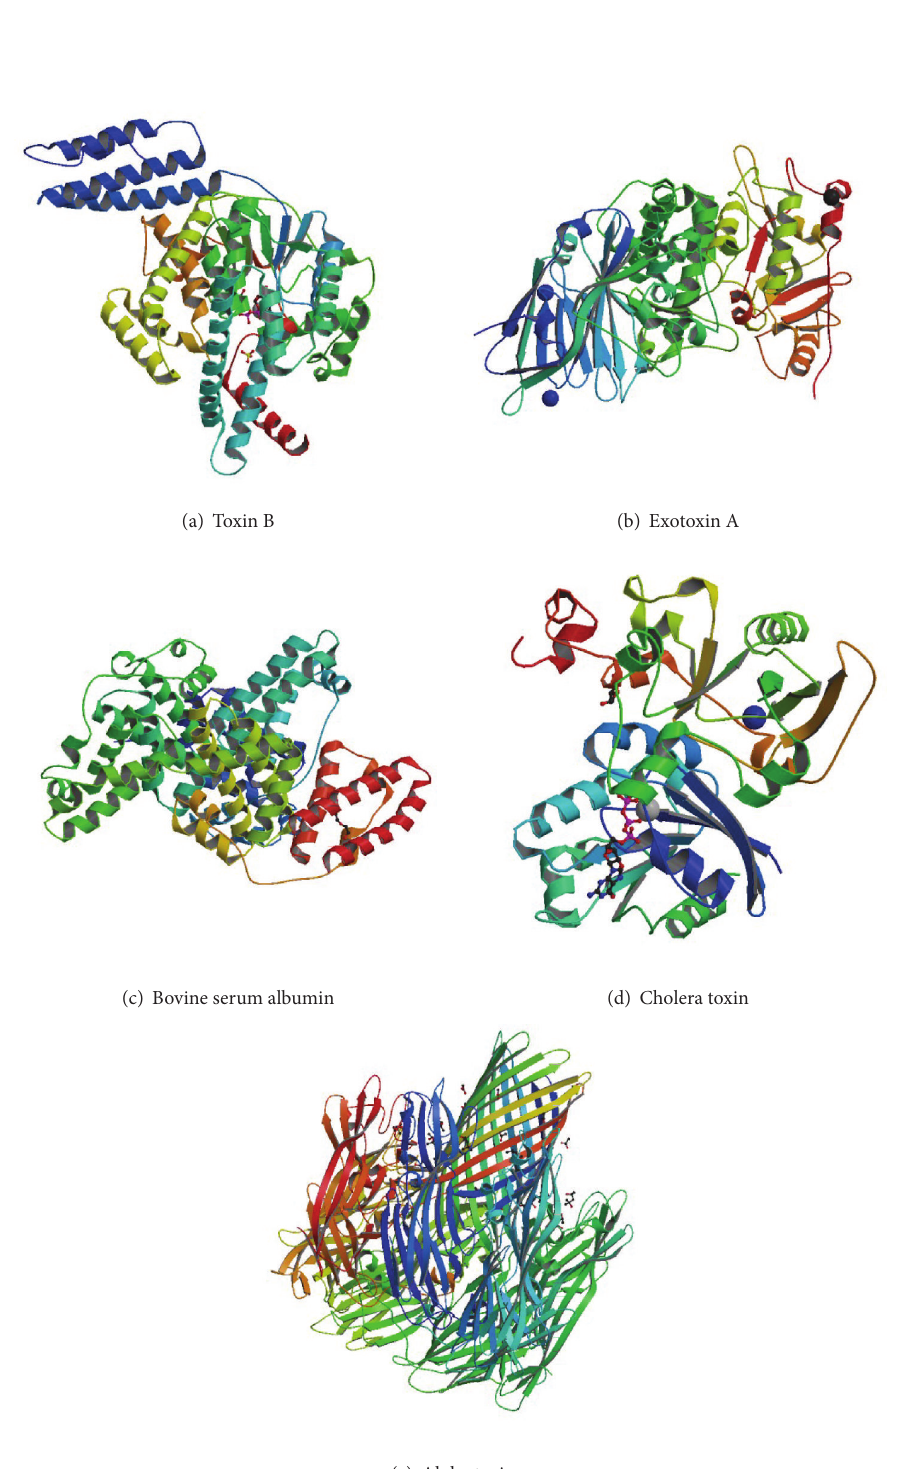
Figure 2: Structures of targets used in the SELEX scheme and cross binding assays. (a) Ribbon structure of the selection target, Clostridium difficile toxin B (PDB 2BVM, 270 kDa) [54]. ((b), (c), (d), and (e)) Ribbon structure of Pseudomonas aeruginosa exotoxin A (PDB 1IKQ, 66 kDa) [55], bovine serum albumin (PDB 4F5S, 66.5 kDa) [56], Vibrio cholerae cholera toxin (PDB 2A5D, 84 kDa) [57], and Staphylococcus aureus alpha toxin (PDB 3ANZ, 33 kDa) [58], used in negative rounds of selection and cross binding